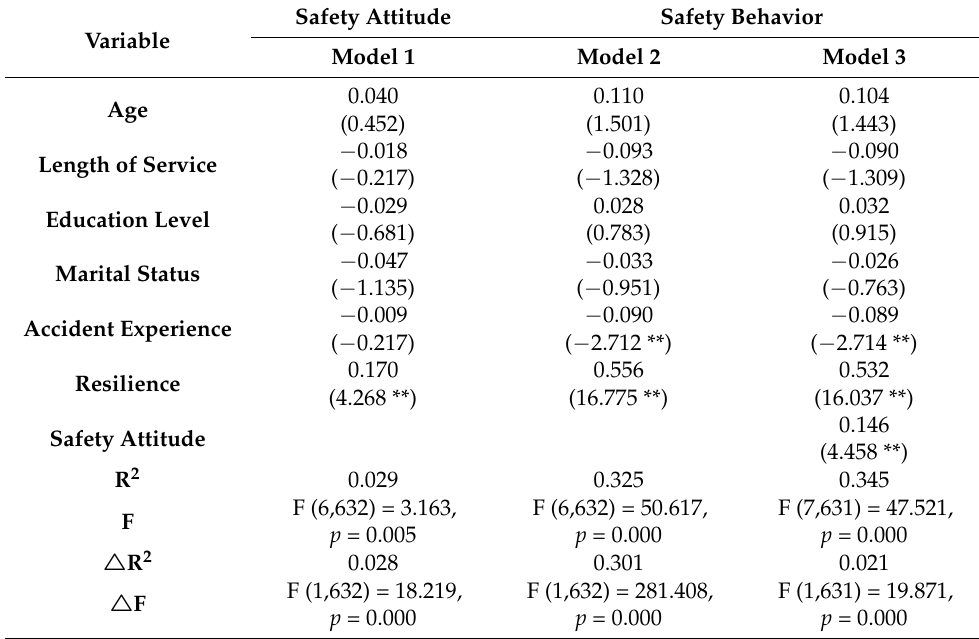
Table 16. Regression analysis of the mediating role of safety attitude (N =